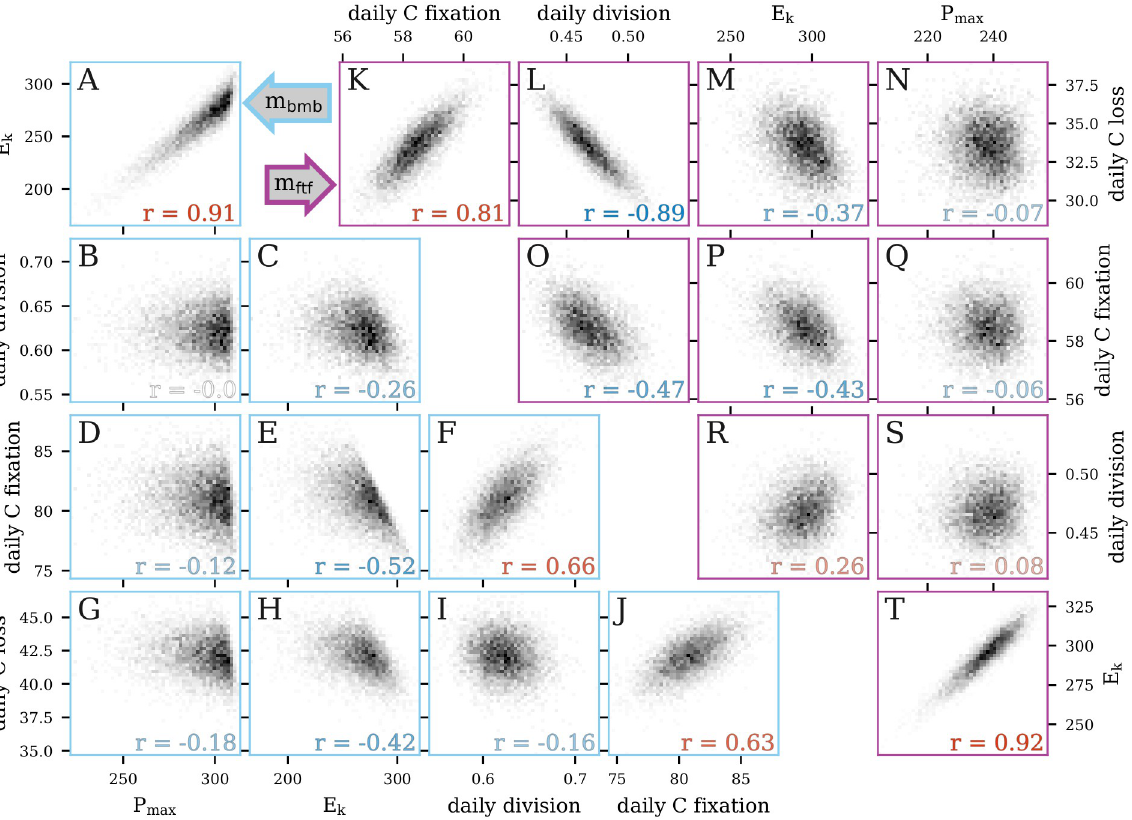
Fig 6. Bivariate posterior distributions. Scatter plots of the bivariate posterior distributions of select parameters for the models (A-J) m bmb and (K-T) m ftf